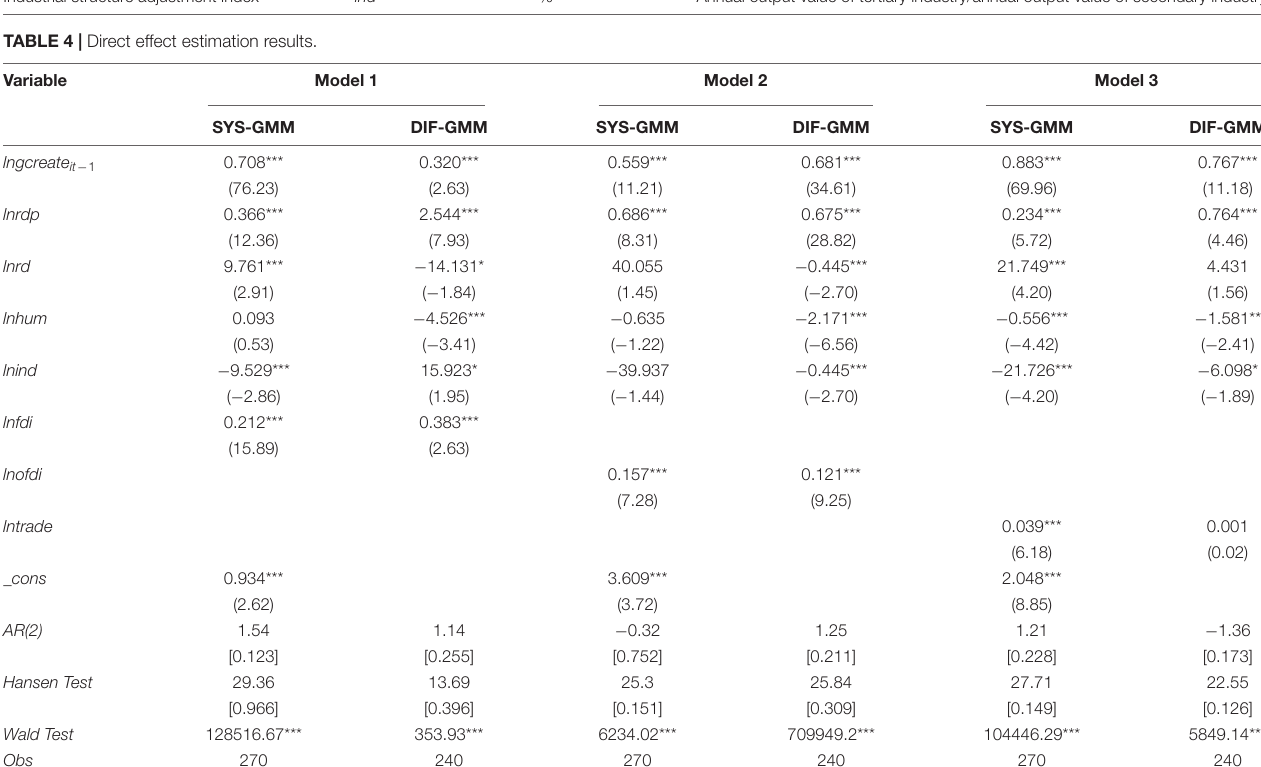
TABLE 4 | Direct effect estimation